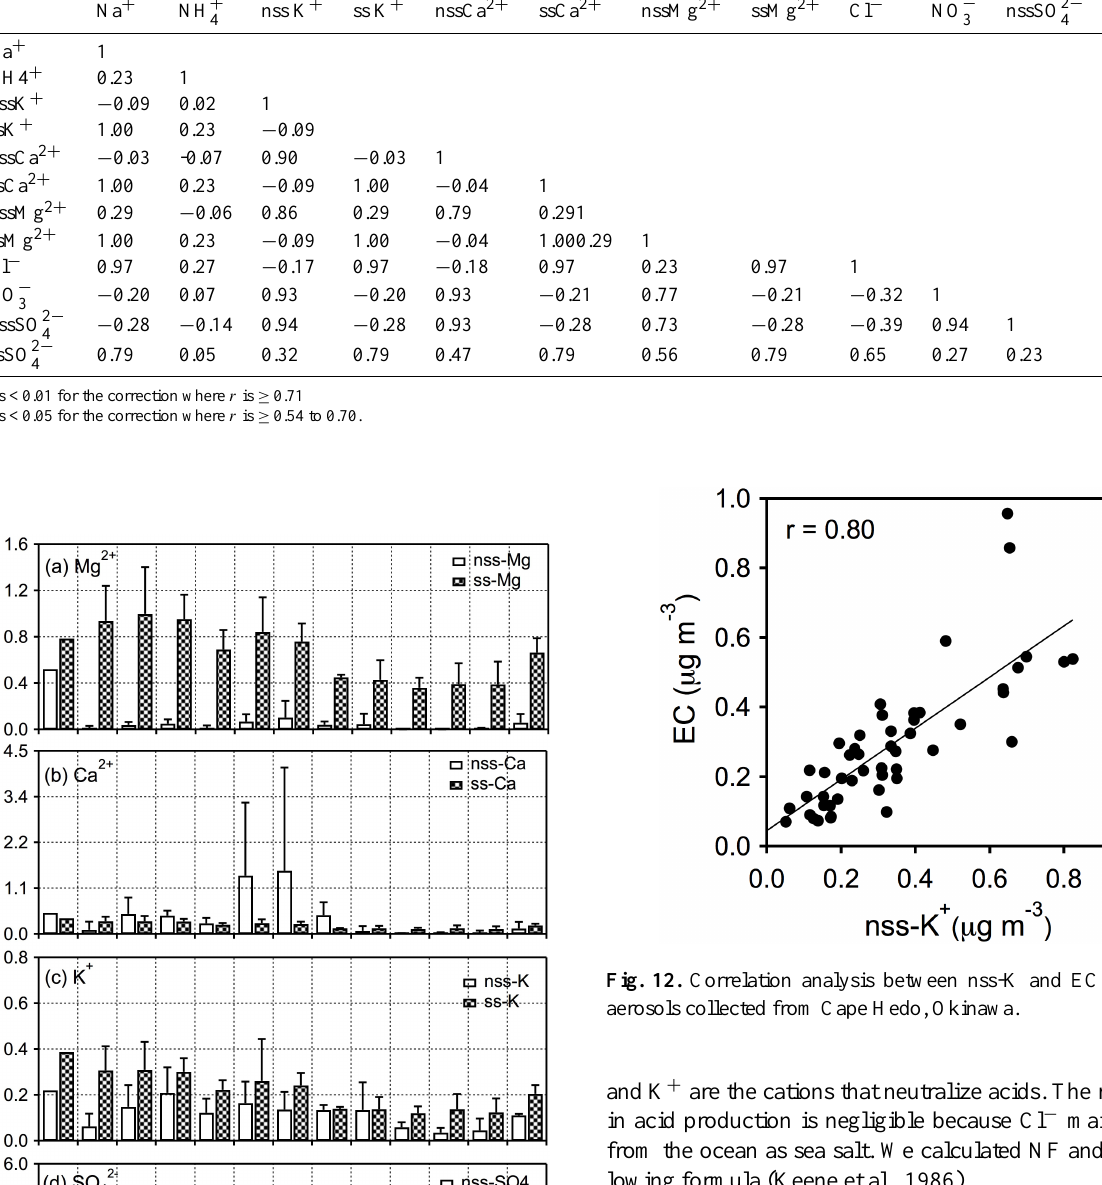
Fig. 11. Estimated mass concentration of sea salt (ss) and non-sea salt (nss) component of (a) Mg 2 + , (b) Ca 2 + , (c) K + , and (d) SO 2 − in ambient aerosols collected from Cape Hedo, Okinawa.